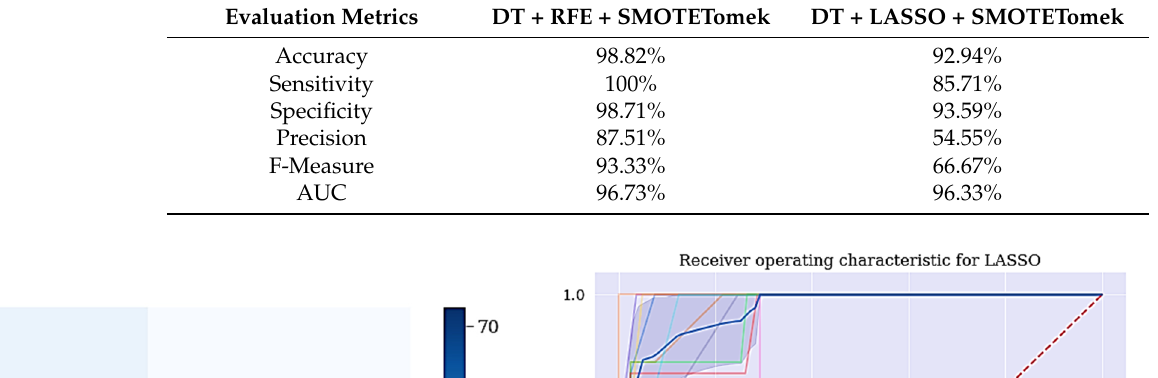
Table 6. Results of DT with selected features and balanced classes.